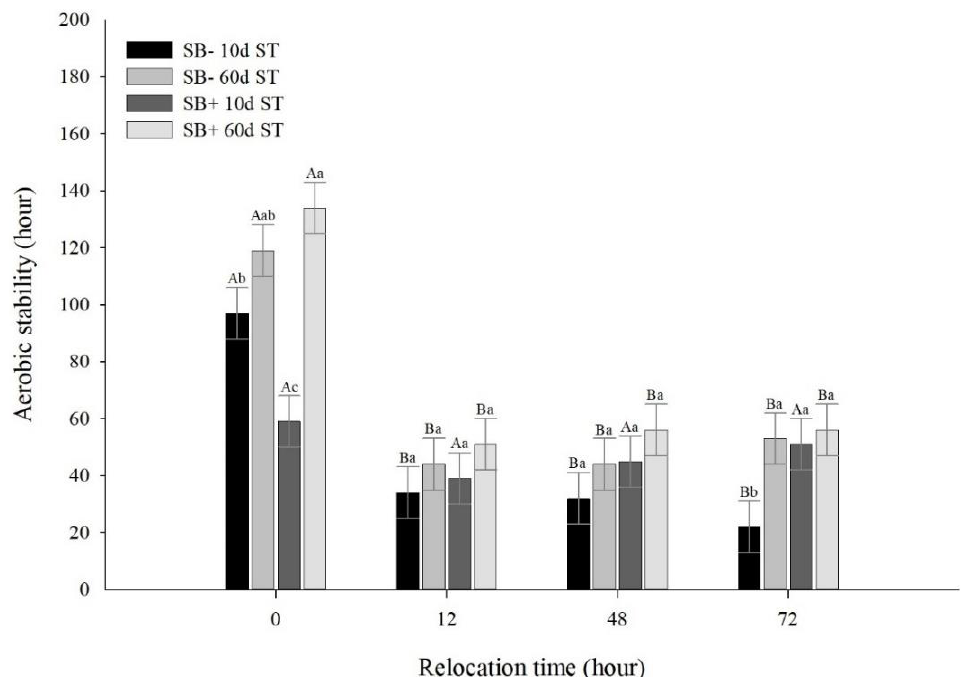
Figure 2. The effects of the additive application (SB) × relocation time (R) × storage time (ST) interaction (SB × R × ST) on the aerobic stability (AS) of sugarcane silage. SB − , without additive; SB+, with sodium benzoate at 2 g · kg − 1 on a fresh matter basis. Means followed by lowercase letters differ from each other within each relocation time according to Tukey’s test ( p > 0.05). Means followed by uppercase letters differ between relocation times according to Tukey’s test ( p > 0.05).